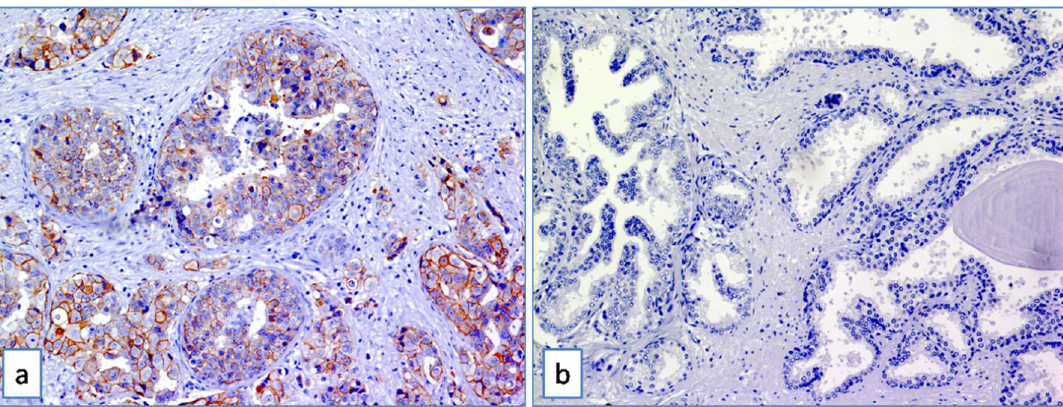
Figure 1. ( a ) ABCB5 staining on breast cancer tissue used as positive control (Immunoperoxidase stain; original magnification 150 × ); ( b ) absence of expression of ABCB5 in benign prostatic tissue used as negative control (Immunoperoxidase stain; original magnification 150 × ).